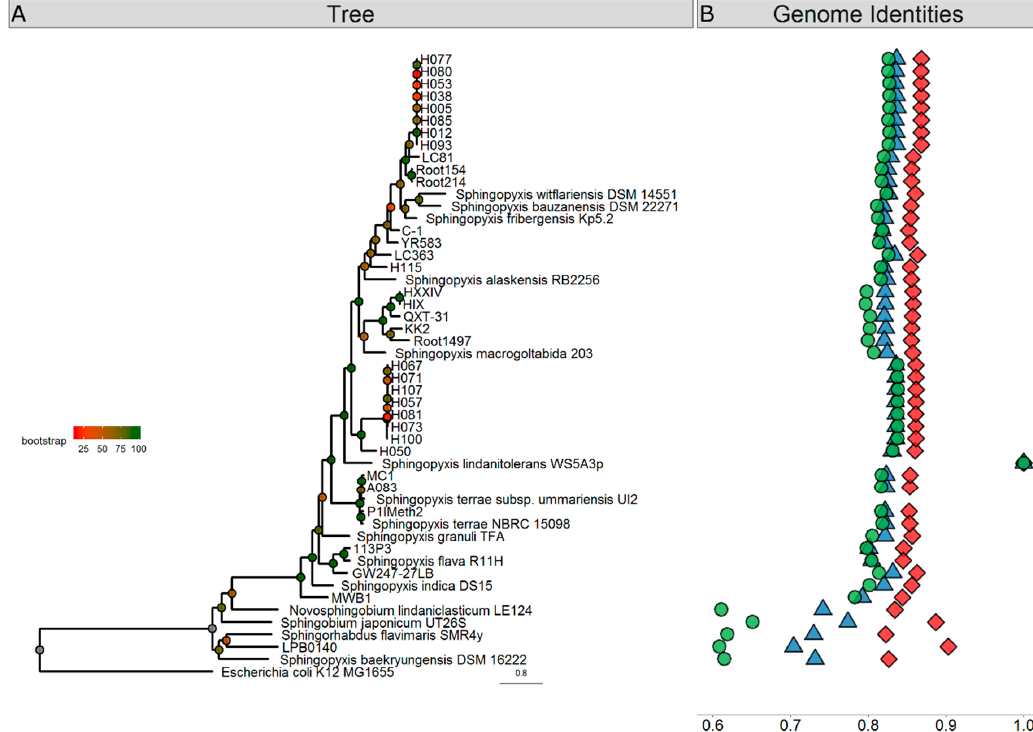
Figure 1. Phylogenetic analyses of Sphingopyxis genomes. ( A ) Phylogenetic relationship of Sphingopyxis genomes based on a maximum likelihood analysis of 400 conserved protein sequences. Branches are colored according to bootstrap values, which are presented on the nodes. The bar represents 0.8 substitutions per site. The WS5A3p branch is indicated with a blue diamond. The blue shaded box contains outgroup genomes included in the analysis. ( B ) Sequence similarity of analyzed Sphingopyxis genomes comparing to WS5A3p strain based on ANIb (blue triangle), ANIm (red diamond) and AAI (green circle).